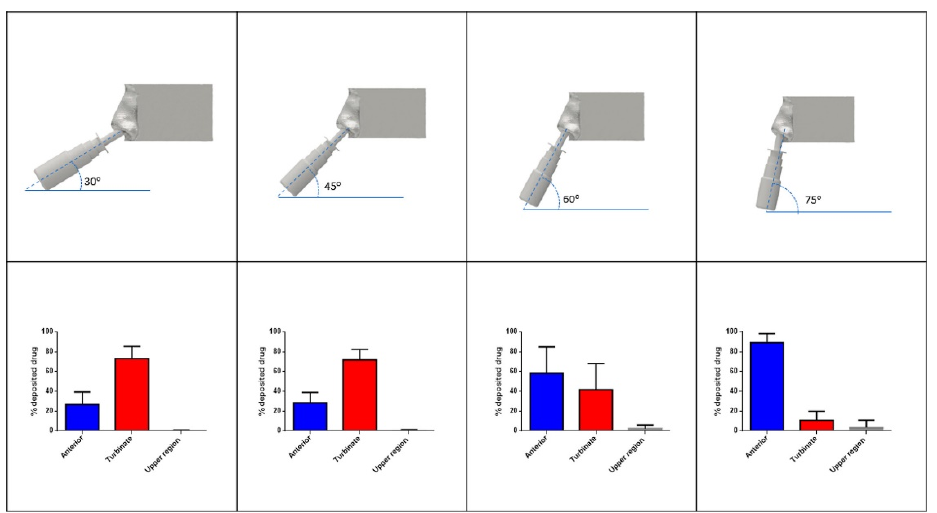
Figure 6. Percent nasal deposition after administration of 0.8% hypermellose cromolyn sodium nasal spray ( n = 10). Deposition was evaluated after dosing using four different administration angles. The nasal cast was segmented to highlight deposition in three regions of the nose: anterior (blue), turbinate region (red), and upper region (grey) [28].